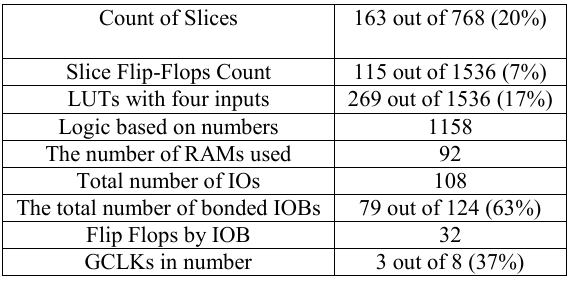
Table 1. Device Utilization Summary.